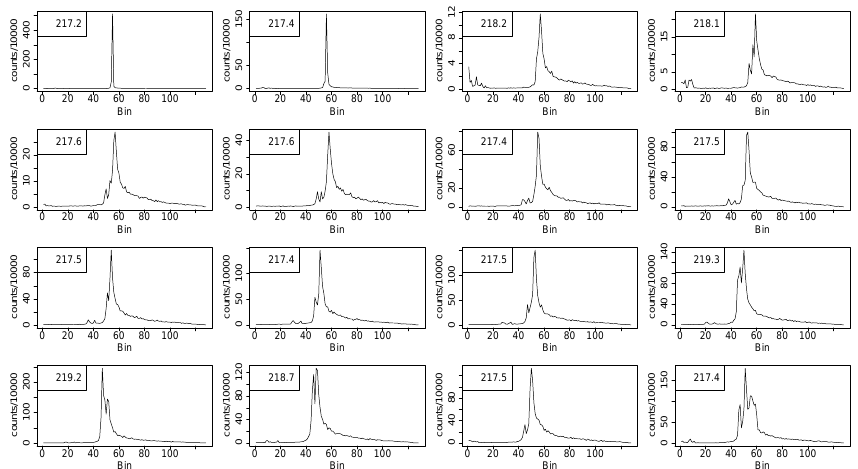
Figure A2. Waveform examples for the Canadian Lake Kiskittogisu. The legend displays the retracked surface elevation.